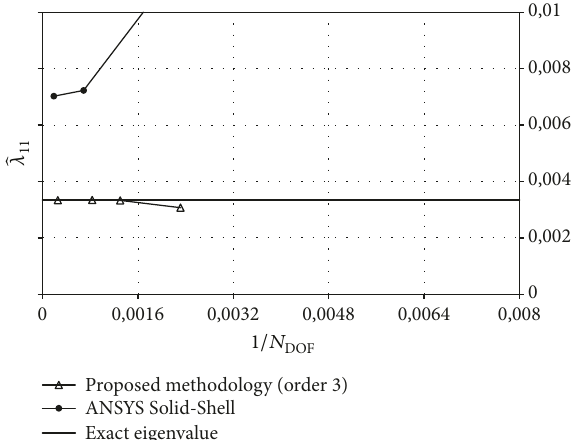
̂𝜆 1/𝑁 ℎ -con- 22 versus DOF (